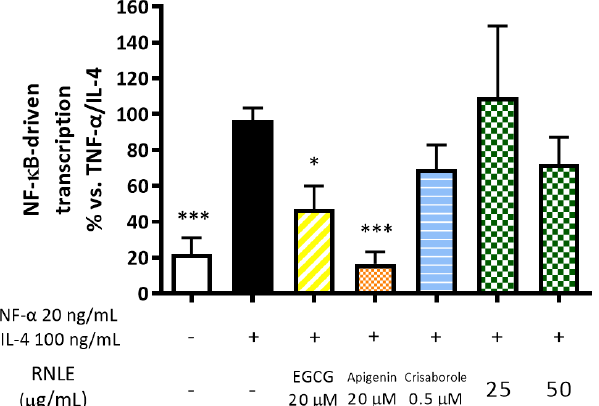
Figure 12. Effect of RNLE treatment (25–50 µg/mL) on NF-κB-driven transcription in HaCaT cells stimulated with a combination of IL-4 and TNF- α (100 ng/mL + 20 ng/mL, 6 h). ( − )-Epigallocatechin stimulated with a combination of IL-4 and TNF-α (100 ng/mL + 20 ng/mL, 6 h). (−)-Epigallocate- 3-gallate (EGCG) 20 µ M, apigenin 20 µ M, and crisaborole 0.5 µ M were used as the reference com- chin 3-gallate (EGCG) 20 µM, apigenin 20 µM, and crisaborole 0.5 µM were used as the reference compounds; * p < 0.05, *** p < 0.001 vs. stimulus. pounds; * p < 0.05, *** p < 0.001 vs.